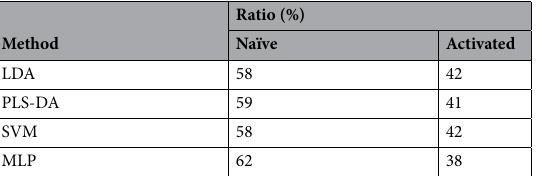
Table 3. Activation ratio by classifier using supervised machine learning (linear discriminant analysis (LDA), partial least squares discriminant analysis (PLS-DA), support vector machine (SVM), and neural network (multilayer perceptron,